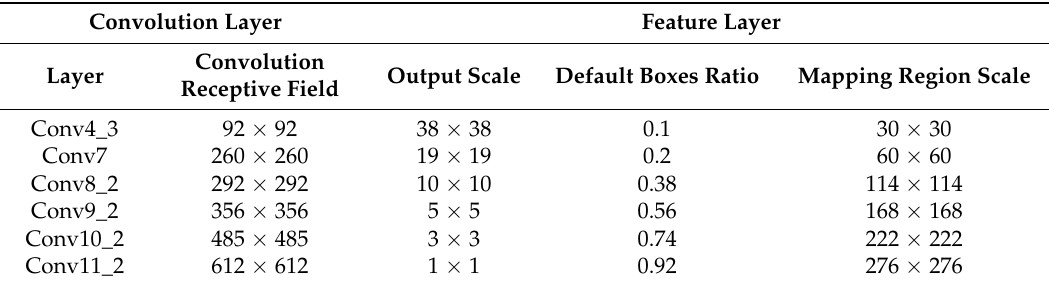
Table 1. Convolution receptive fields and mapping regions of. the default bounding boxes in Single Shot Multibox Detector (SSD)_300 × 300.